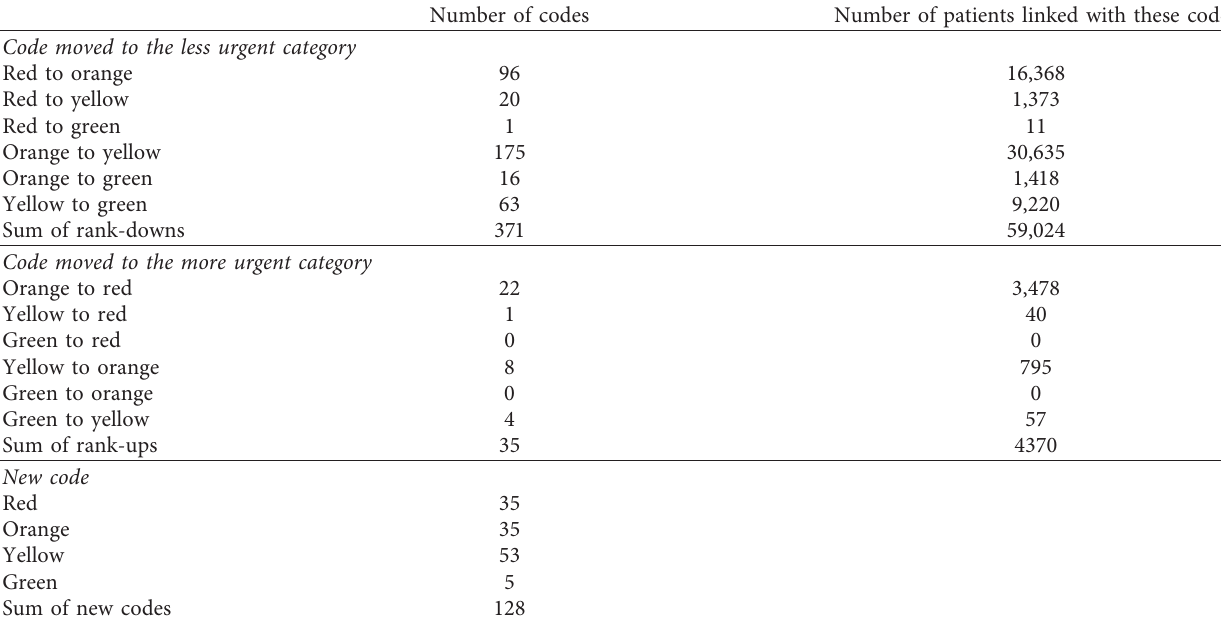
Table 2: Number of revised codes with category and of patients linked by each